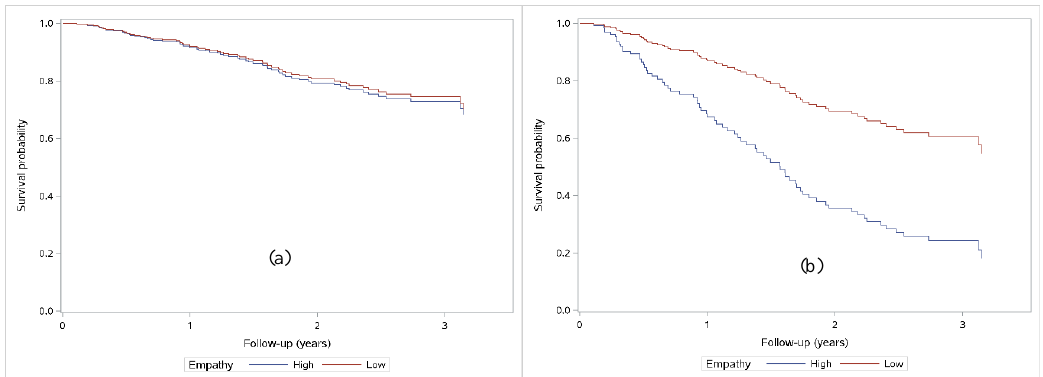
NSCL: Non-small cell lung cancer; SCL: Small cell lung cancer; n = 143 (due to missing data in some variables), -2LL = 587.8, Akaike Information Criterion (AIC) = 625.8, Schwarz Bayesian Criterion (SBC) = 668.8. EGFR: Epidermal Growth Factor Receptor; ALK: Anaplastic Lymphoma Kinase; ROS: ROS proto-oncogene 1, receptor tyrosine kinase. proto-oncogene 1, receptor tyrosine kinase.